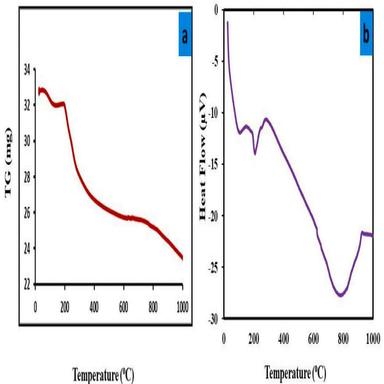
TGA (a) and DSC results of Mus/St/MNPs composite.